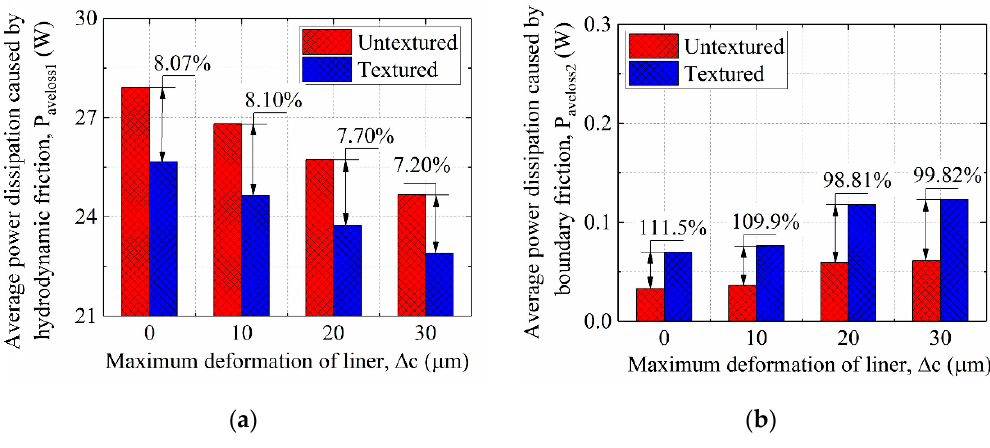
Figure 13. Average power dissipation caused by the hydrodynamic friction and boundary friction for di ff erent maximum deformations of liner: ( a ) Average power dissipation caused by the hydrodynamic friction; ( b ) average power dissipation caused by boundary